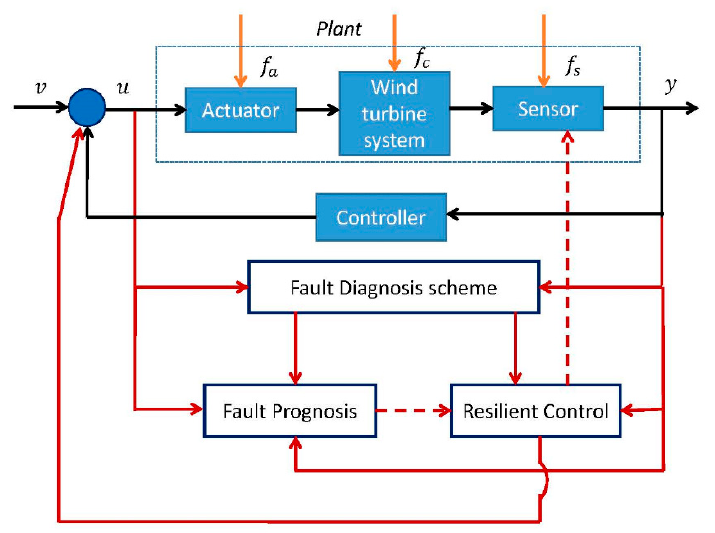
Figure 3. Schematic diagram of fault diagnosis, prognosis and resilient